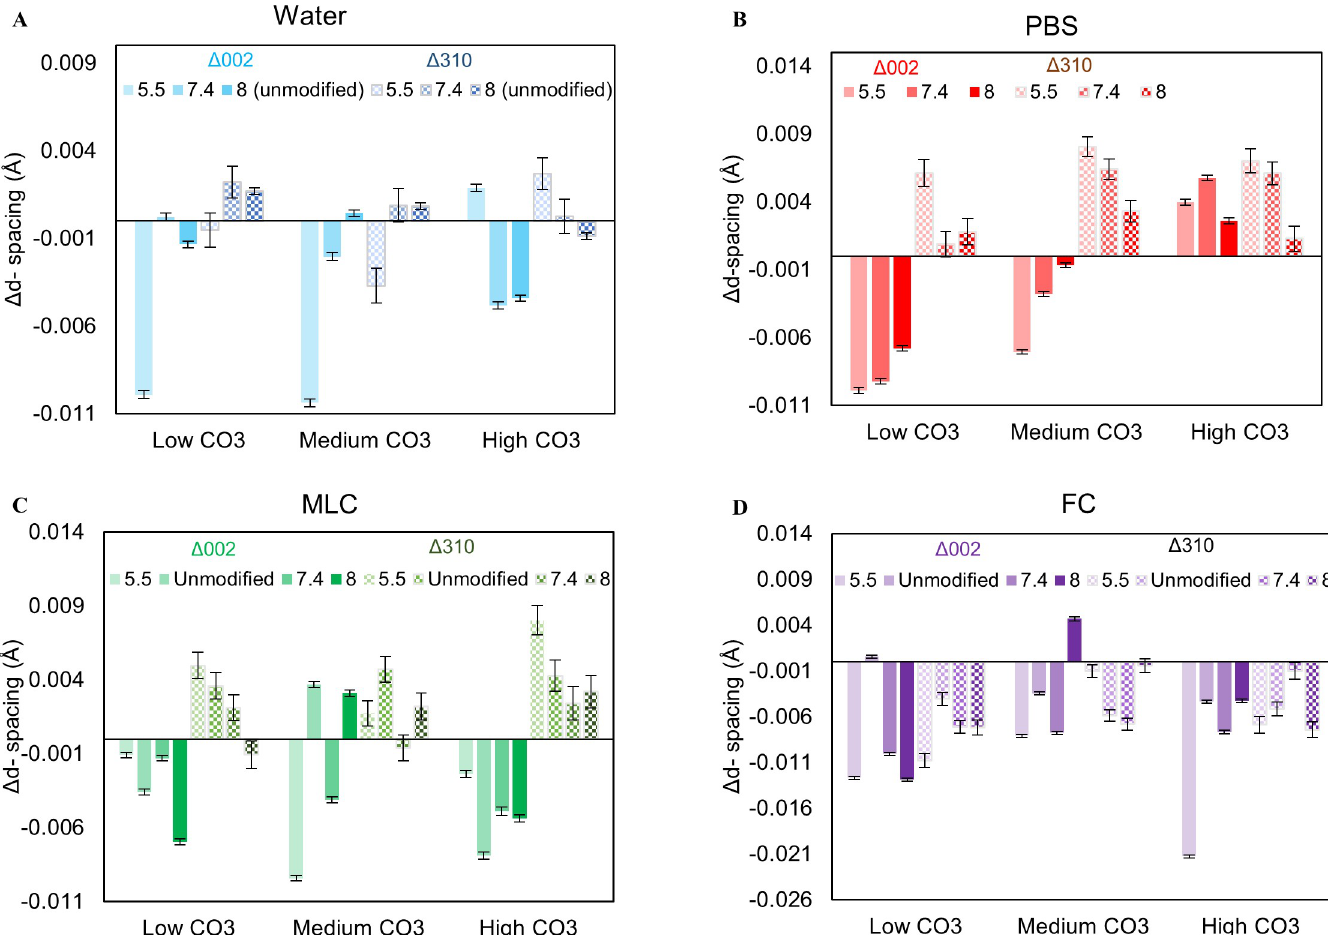
Fig 7. D-spacing of the c-axis (002) and a-axis (004) of CAP after exposure. Generally, the c-axis decreased, and the a-axis increased for PBS and MLC (B, C) . For FC, both c-axis and a-axis decreased (C) . These changes in d-spacing specify structural changes in apatite after solution exposure. Water exhibited variations of these axes, which is indicative of no structural differences of CAP (A) . Error bars account for XRD peak fitting errors.